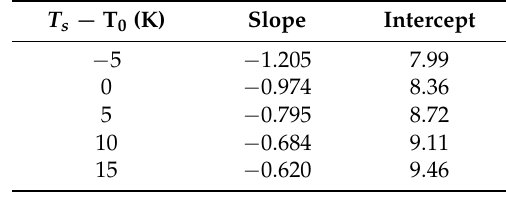
Table 1. For water vapour content (W) greater than 1 g/cm 2 , the slope and intercept of the linear relationship between constant C in Equation (1) and W for a given surface-air temperature difference T s − T 0 . T s − T 0 (K) Slope